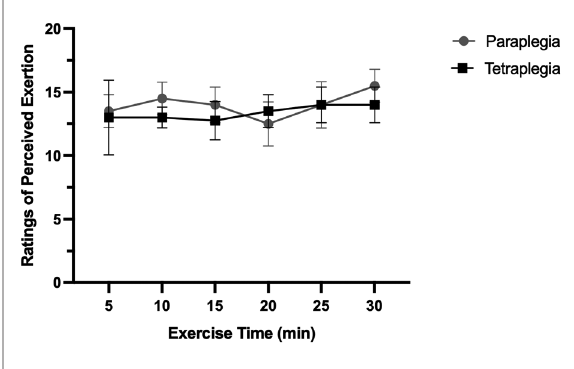
FIGURE 1 Ratings of perceived exertion over the 30-minute exercise bout in paraplegic and tetraplegic